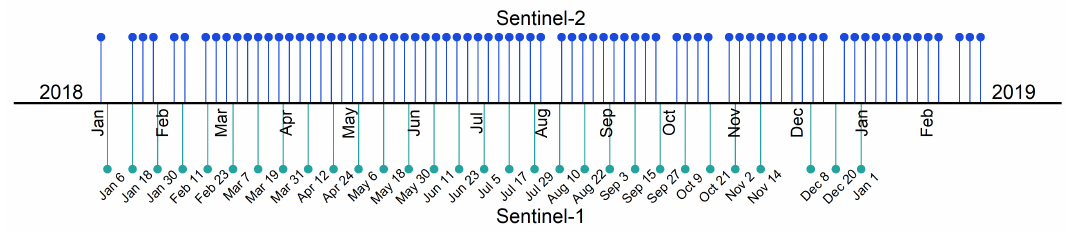
Figure 3. Sentinel-1 and Sentinel-2 aquisition dates,